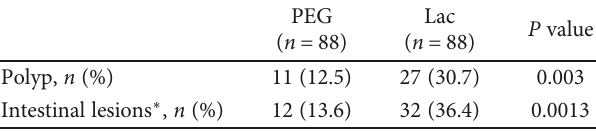
Table 5: Detection of polyp and intestinal